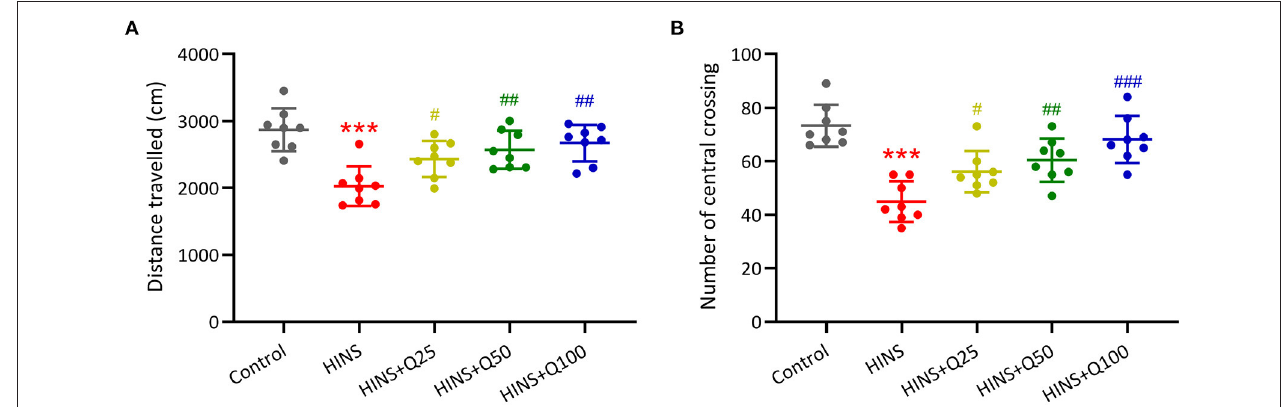
FIGURE 2 | Quercetin administration following HINS attenuated anxiety-related behavior of rats in Open-Field test. Total traveled distance (A) and number of central crossings (B) over 10min exploring the arena were recorded. Eight rats were used to recorded in each group. Mean ± SD. *** p < 0.001 compared to control. # p < 0.05, ## p < 0.01, and ### p < 0.001 compared to